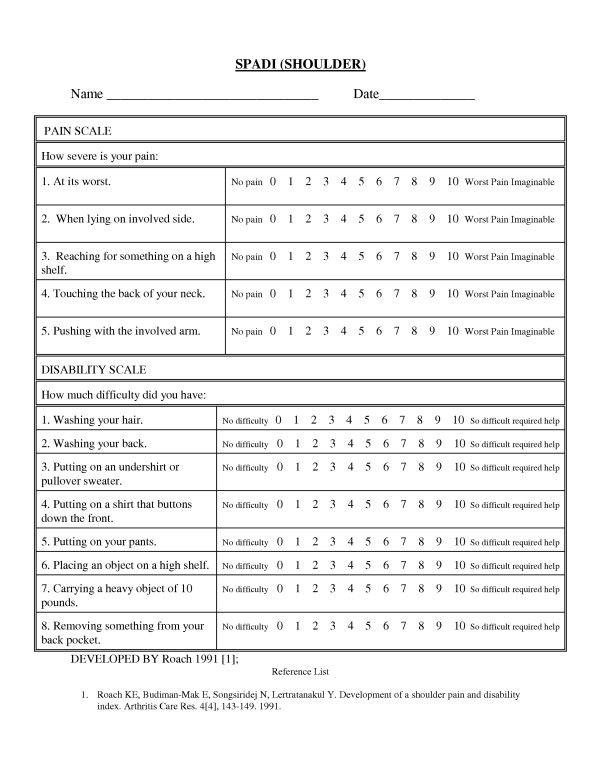
The Shoulder Pain and Disability Index (SPADI). This is a numeric version of the SPADI, used with permission of the developer K Roach.